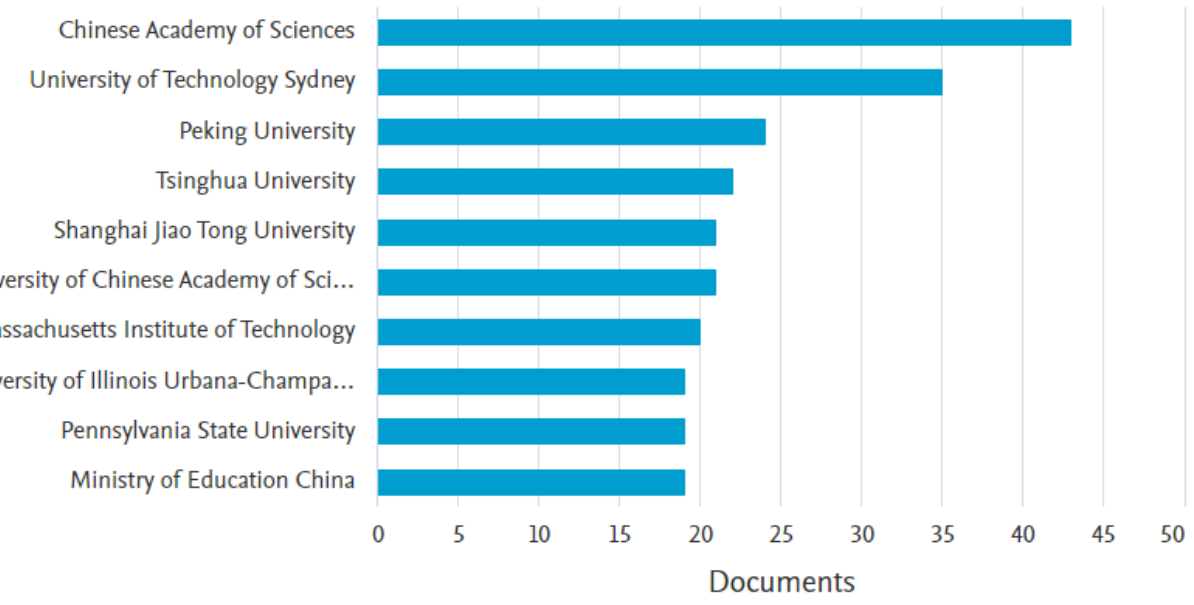
Figure 4. Documents by subject Area for “machine learning” AND “knowledge management” .